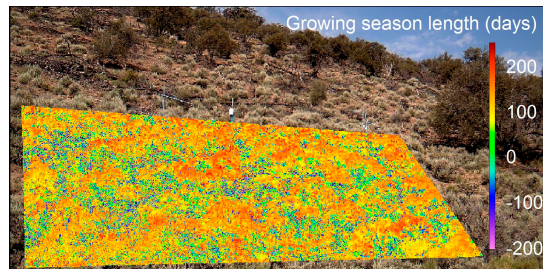
Figure A3. Initial spatiotemporal analysis that was confounded by interspace, which lead to the filtering described in Figure 8. The red and yellow colors closely map with sagebrush canopy, while green and blue closely map with interspace but have a negative growing season length .